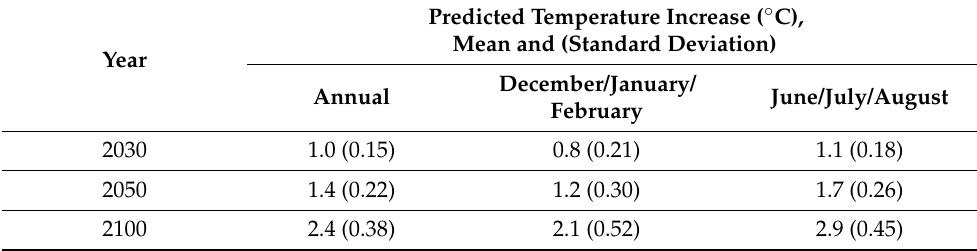
Table 2. General circulation model estimates of temperature increases in Egypt